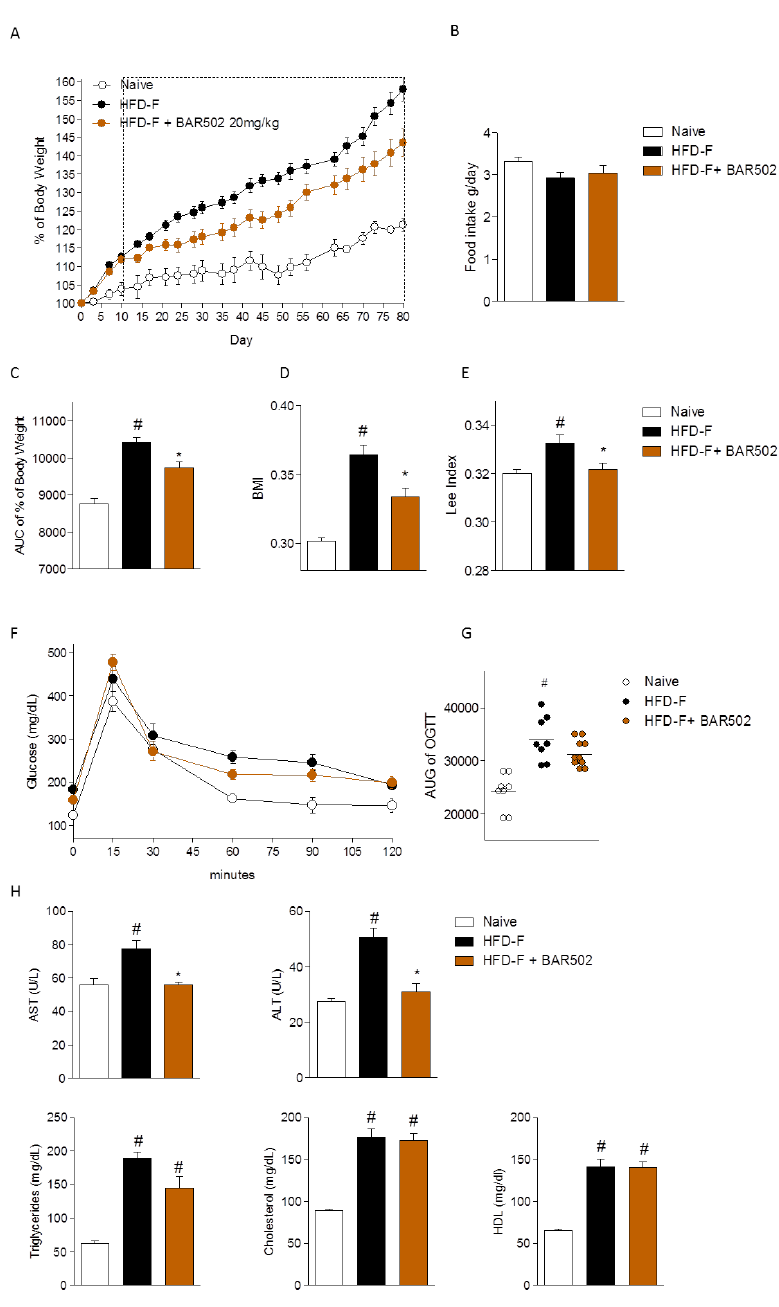
Figure 1. BAR502 reduces body weight gain, ameliorated insulin resistance and biochemical profile in mice fed a high fat diet and fructose (HFD – F). BAR502, 20 mg/kg/day, was administered by gavage in C57BL/6J male mice starting on day 10 of HFD and fructose for an additional 11 weeks. The data shown are: ( A ) % of body weight; ( B ) Food intake (g/day); ( C ) areas under curve (AUCs) of body weight expressed in arbitrary units; Anthropometrical parameters ( D ) body mass index (BMI) and ( E ) Lee Index, measured at the end of the study; ( F ) Glucose plasma levels response to oral glucose tolerance test (OGTT) and ( G ) AUCs of glucose plasma levels expressed in arbitrary units; ( H ) Plasma levels of aspartate transaminase (AST), alanine transaminase (ALT), Triglycerides, Cholesterol, and HDL and measured at the end of the study. The data shown are mean ± SE of 7– 10 mice/group. In each panel # denotes p < 0.05 versus Naïve mice, * denotes p < 0.05 versus HFD – F mice.